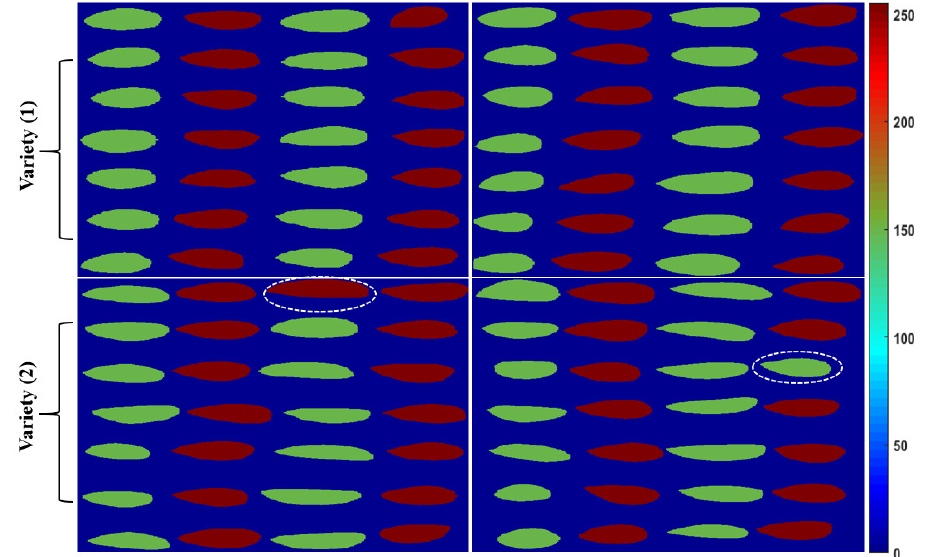
Figure 7. The resultant images of the PLS-DA model from raw data in the first and second variety with 50% detection (red indicates apricot seeds and green indicates almonds), presenting a total image-based classification accuracy of 98%.